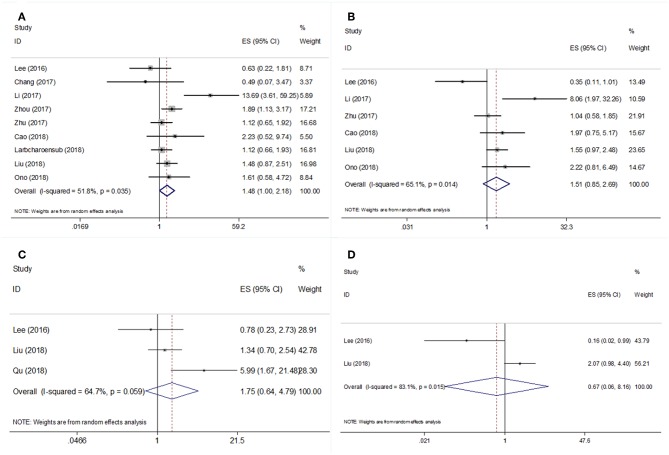
Forest plot diagrams of hazard ratios for correlations between PD-L1 expression and (A) OS, (B) DFS, (C) DMFS, and (D) LRFS.